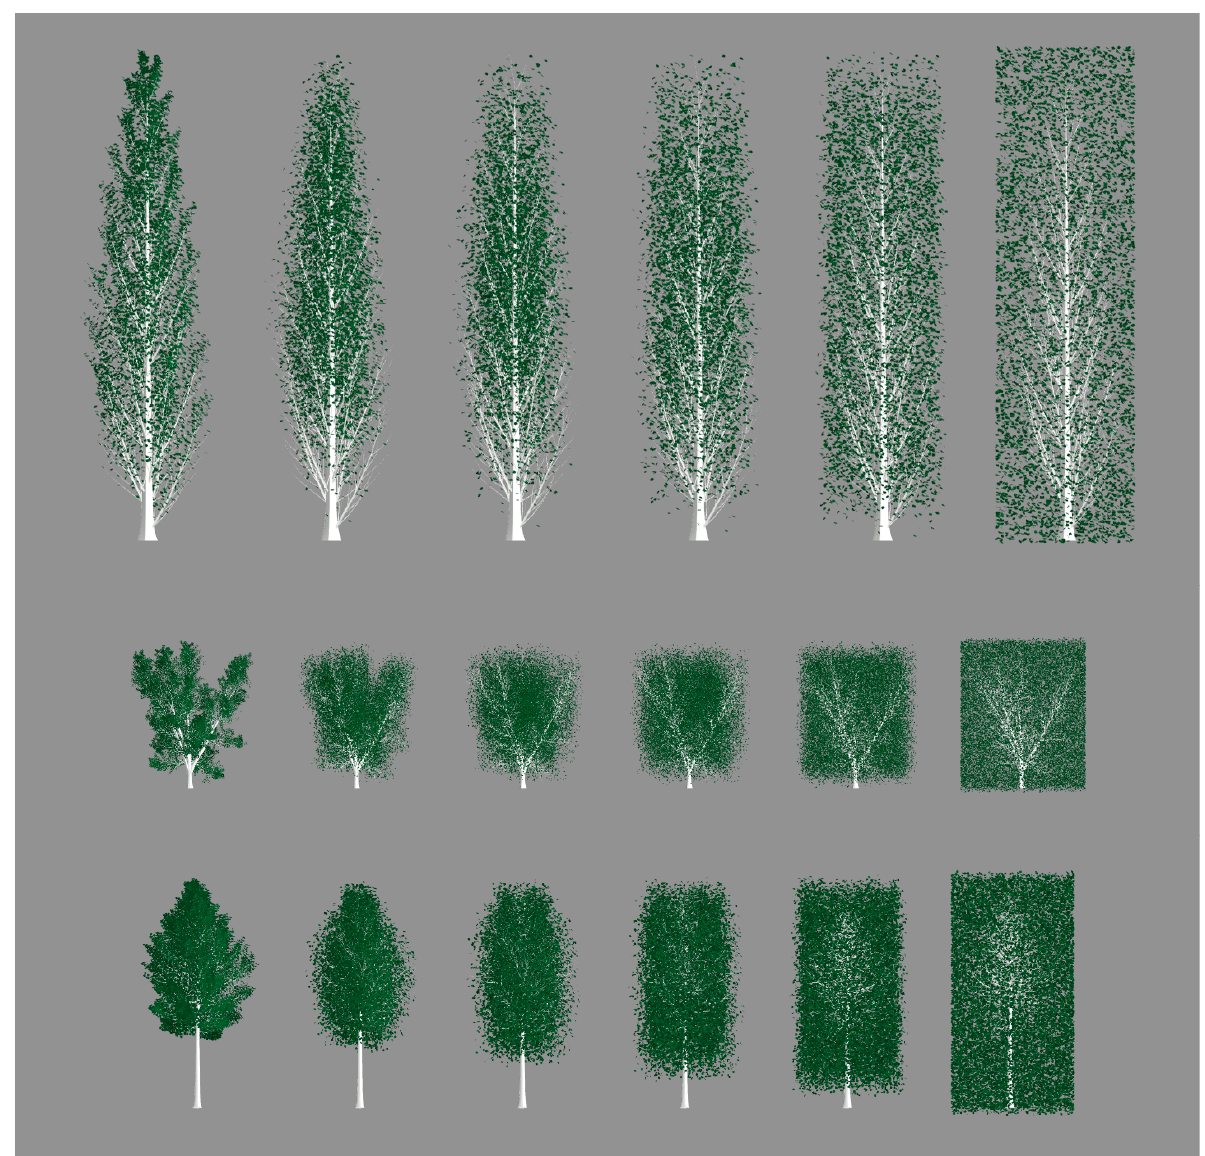
Figure 3: Shown are the different degrees of foliage dispersion for virtual trees constructed with Arbaro. Trees represent poplar, cottonwood, and aspen species, from top to bottom rows,